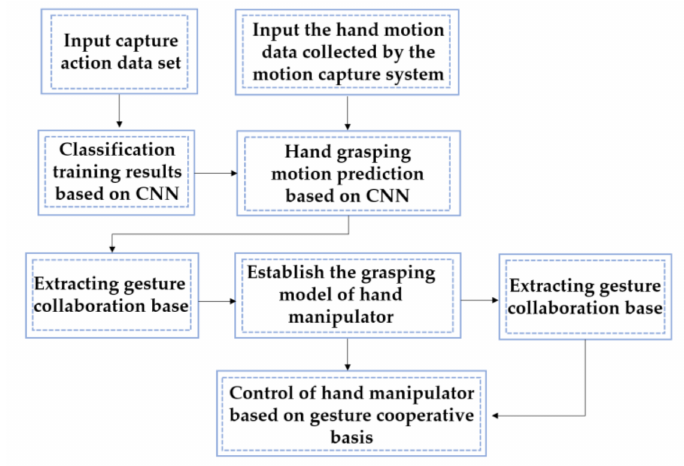
Figure 1. The general architecture of the algorithm and control system.